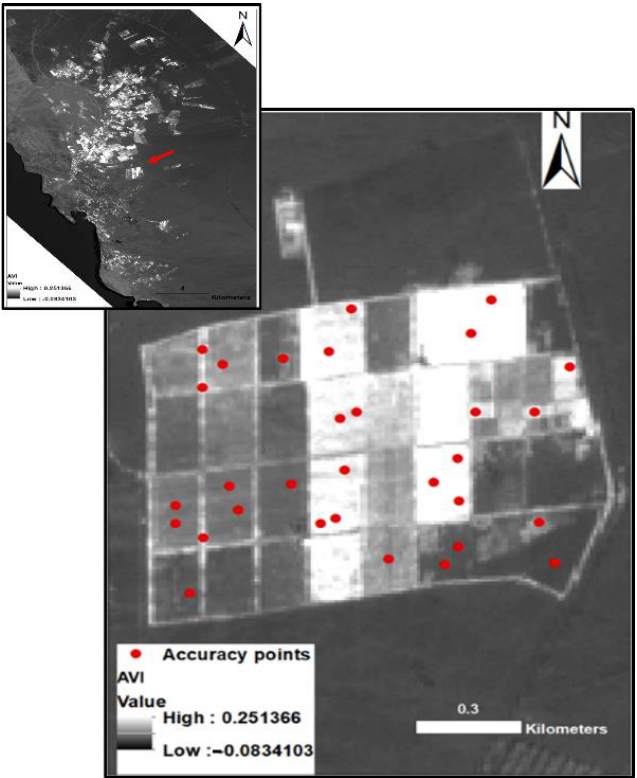
Figure 3. The AVI resulted from the use of the Sentinel 2A (10 m) bands. It shows the accuracy and the high resolution of the data. The accuracy assessment test was applied on one farm containing all the vegetation classes (heavy, moderate, and light). The position of the farm is shown by the red arrow.